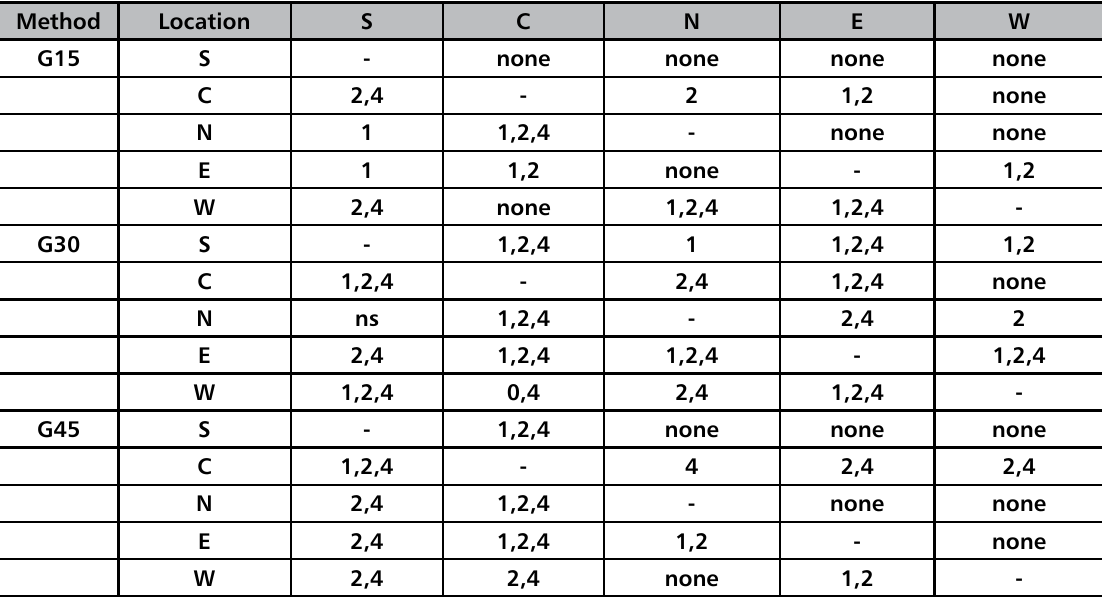
sessile oak seedlings was the fastest in the centres. Independently from the gap size, hornbeam seedlings grew at the highest speed in the middle of the gaps. Furthermore, development was intensive also in the west parts of G15 and G30. In G15, the difference between the central and the west parts was not significant at all during the whole sampling period. Hornbeam grew over sessile oak to the lowest extent in the north parts of the gaps (Figure 6). However, VHD differed significantly only in G30.